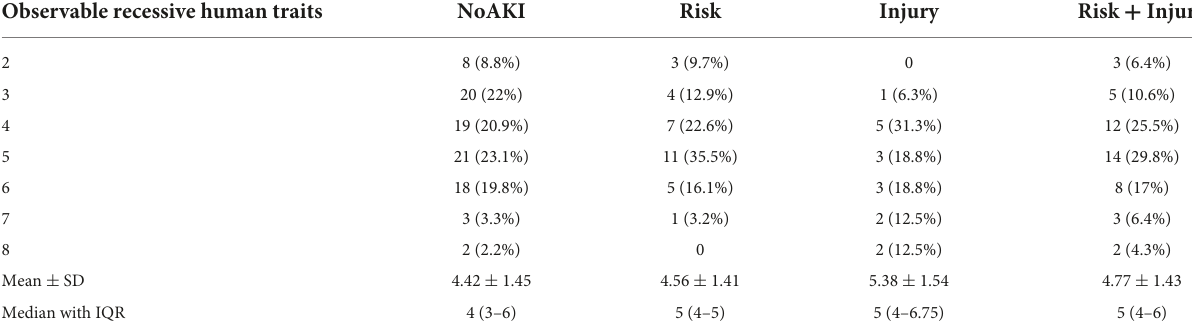
TABLE 4 Frequencies of observable recessive human traits in the different subgroup. Observable recessive human